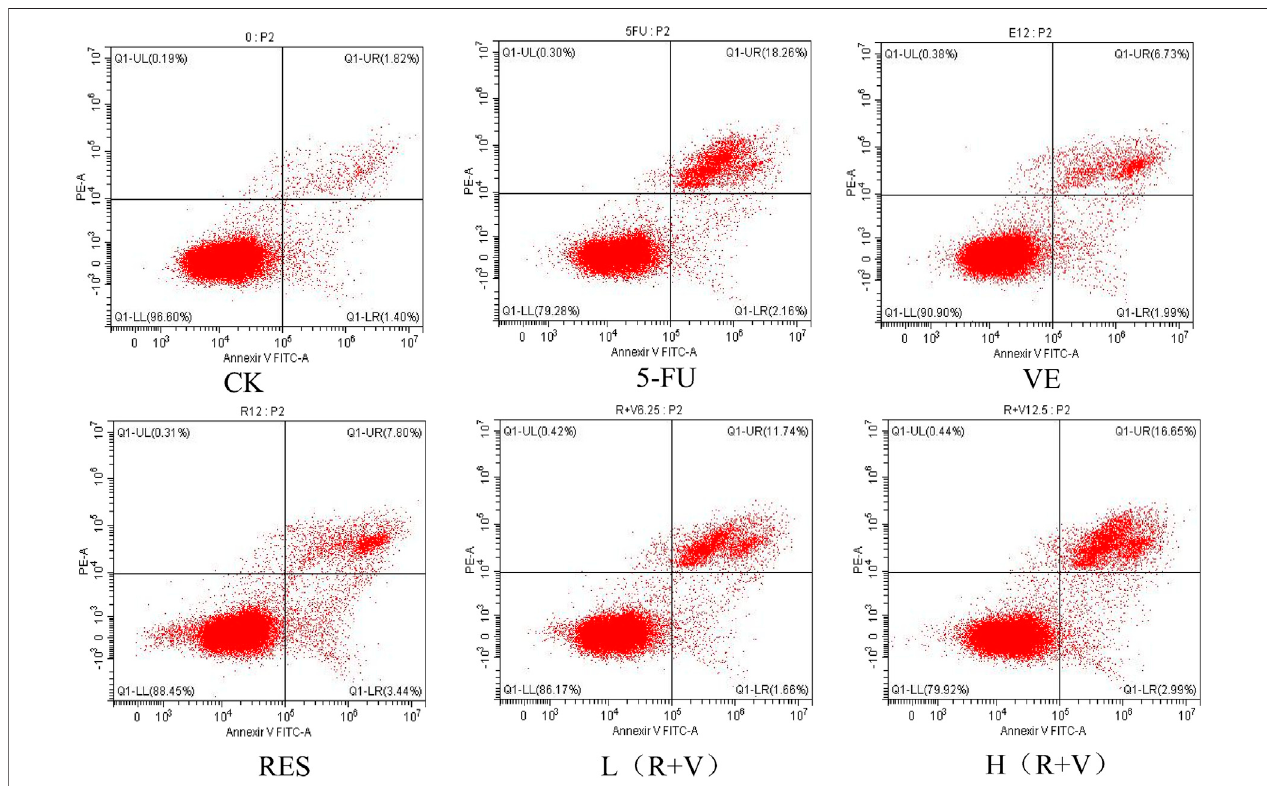
FIGURE 4 | Flow cytometry to determine the effects of different treatments on cell apoptosis.